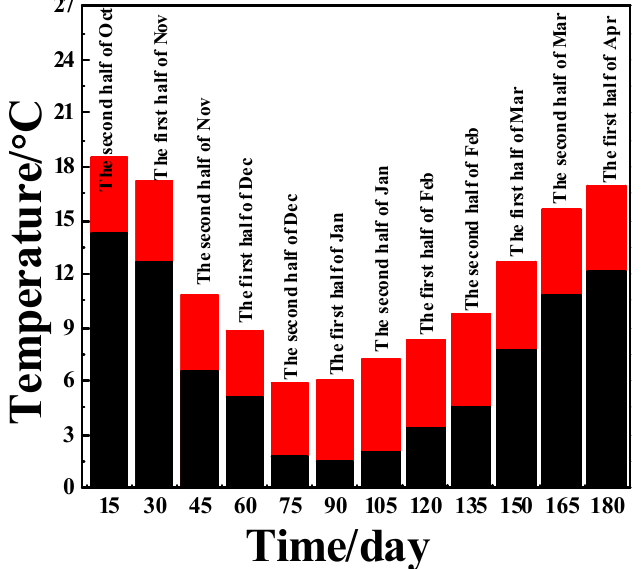
Figure 6. Diagram of average temperature of the testing room and contrast room over time.